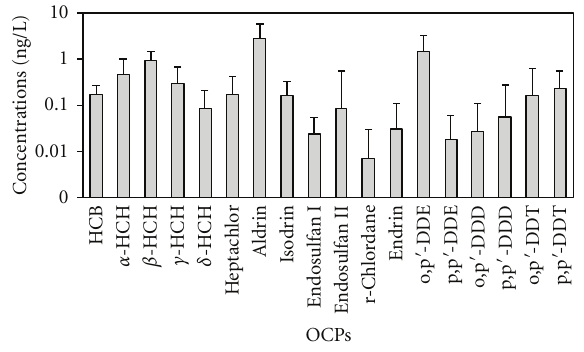
Figure 3: Annual mean concentrations of 18 OCPs in the water from Lake